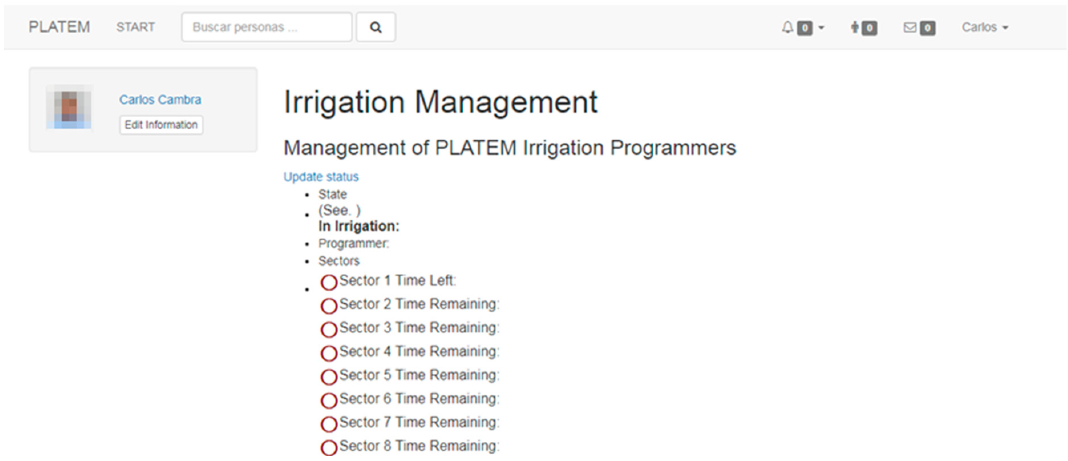
Figure 17. Irrigation controller view.